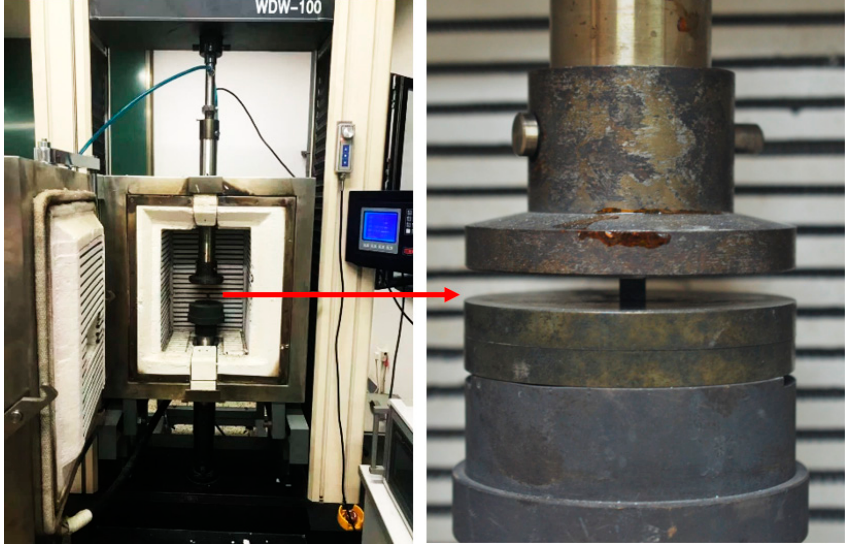
Figure 3. High temperature compression experiment setup.